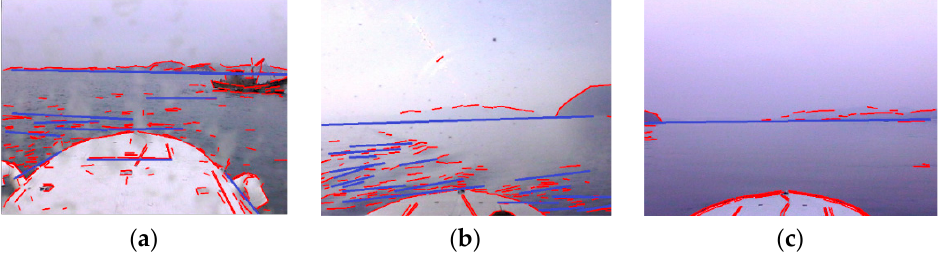
Figure 8. Line feature merging results of optical images in typical adverse weather conditions. ( a – c ) are optical images with improved line features.